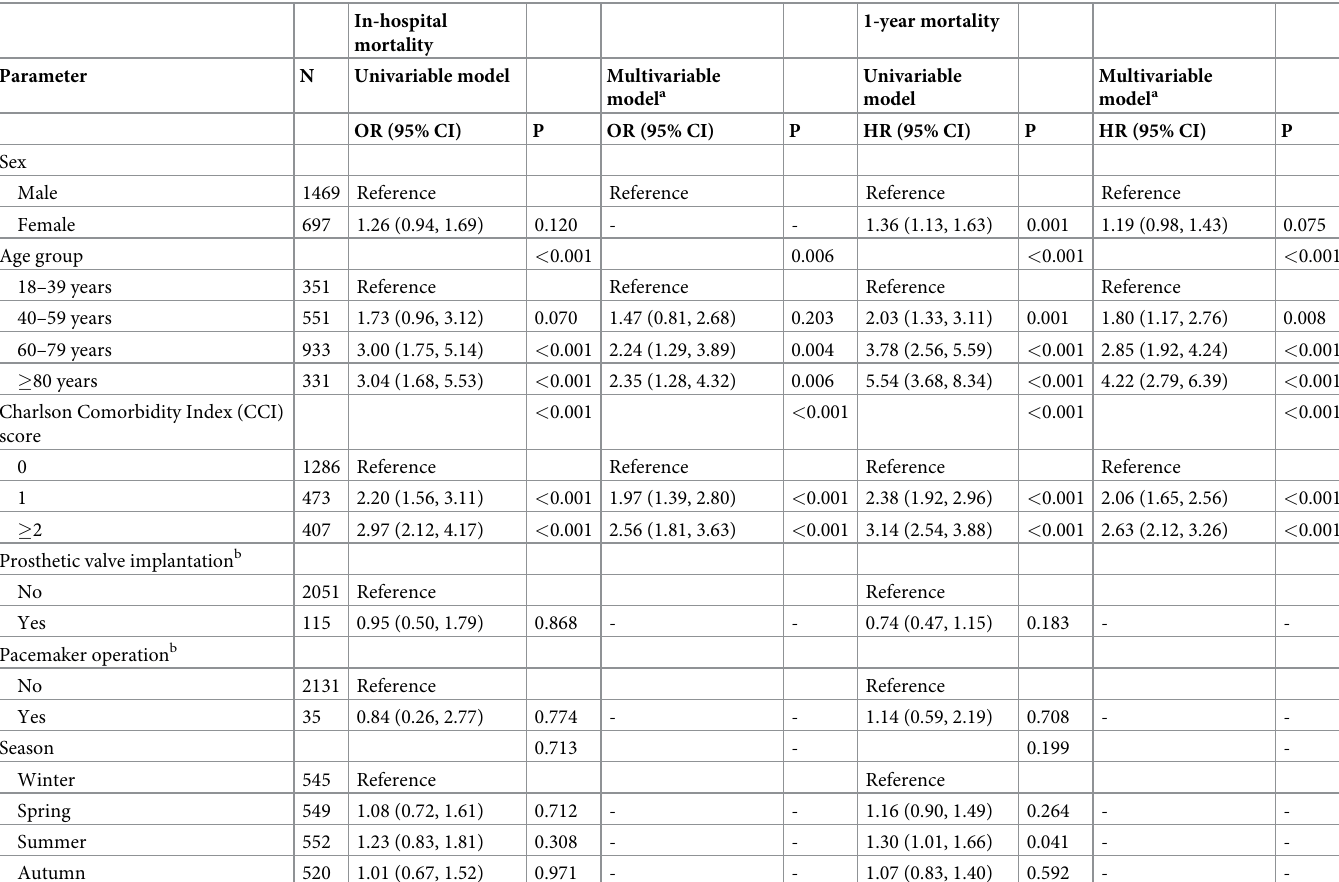
Table 2. Predictors of in-hospital and 1-year mortality after infective endocarditis admission during 2005–2014 in Finland (n =